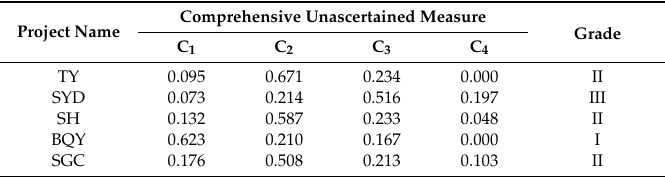
Table 4. The assessment